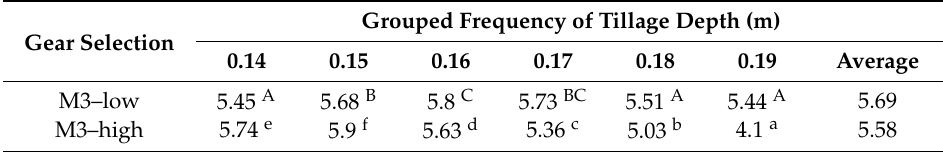
Table 5. Comparison of mean traveling speed (km / h) at di ff erent levels of grouped tillage depth. Gear Selection